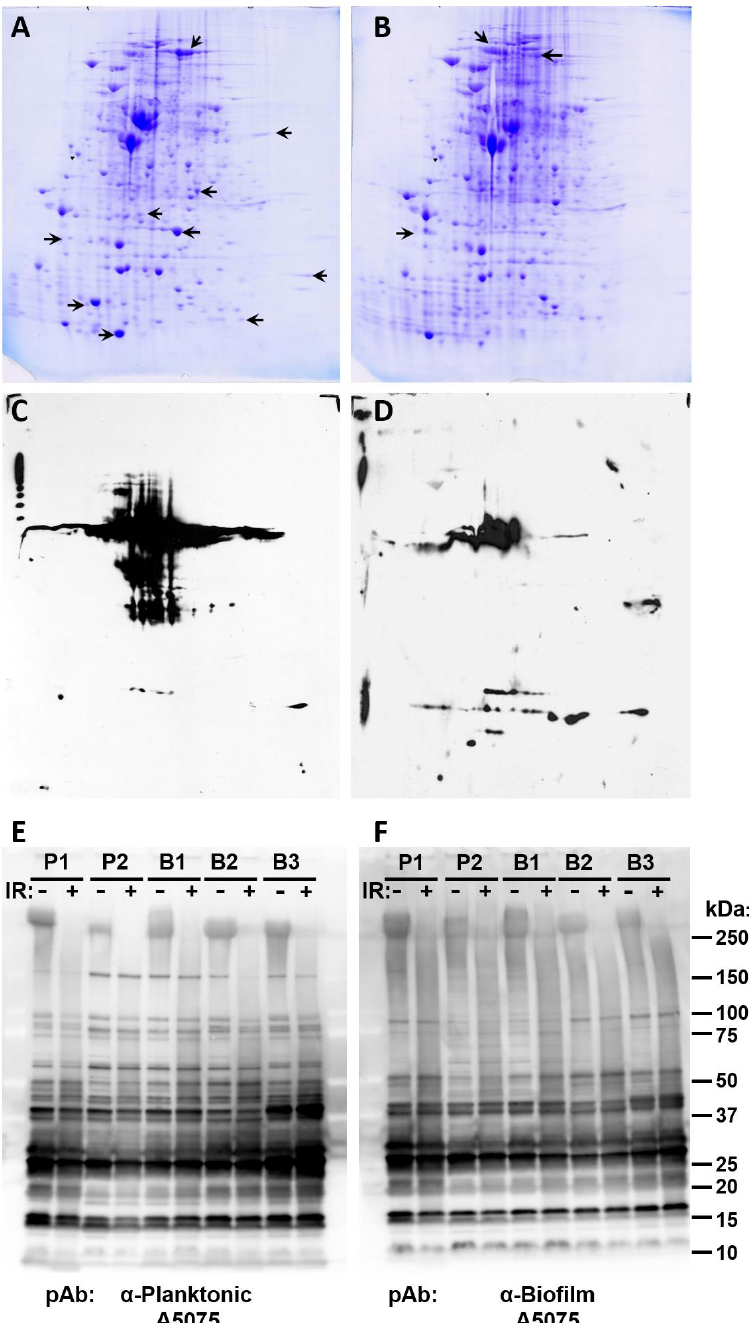
Figure 2. Denaturing gel analysis of proteins from planktonic and biofilm cultures of A. baumannii. Two-dimensional electrophoresis gels are shown of cell lysates from cultures harvested in ( A , C ) planktonic growth phase (P1) or in ( B , D ) biofilm phase (B1). The gels in Panels A and B were stained with Coomassie Blue to show all visible proteins. Arrows point to several proteins that are present or increased in that gel, but that are absent or decreased in the accompanying gel. Replicate gels were transferred to membranes and probed with polyclonal rat antisera raised against A. baumannii (panels C and D). Panel C shows proteins detected from planktonic growth phase (P1) and Panel D shows proteins detected from biofilm phase (B1). Panels E and F show Western blot analysis of P1, P2, B1, B2, and B3 lysates before and after irradiation in the presence of MDP probed with polyclonal rat sera raised against either planktonic ( E ) or biofilm ( F ) forms of A. baumannii